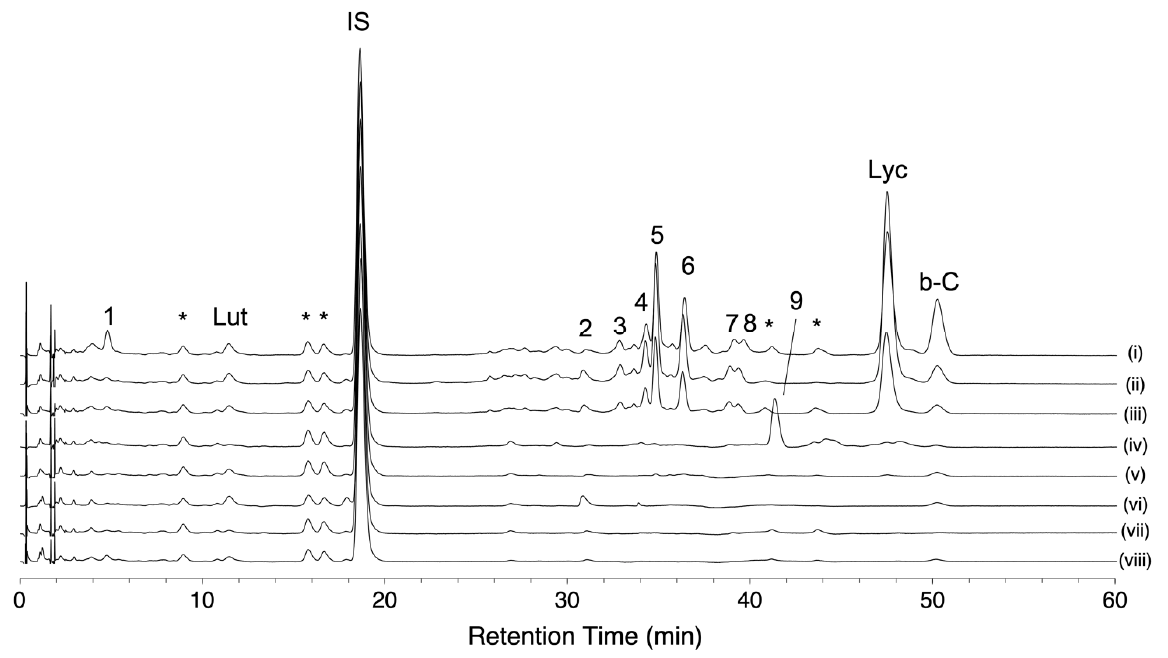
Figure 5. Carotenoid profiles of eight representative varieties analyzed by using HLPC-PDA. Carotenoid profiles were visualized at the wavelength of 450 nm. Each chromatogram shows the pattern of “Ailsa Craig” ( i ), “Bear Creek” ( ii ), “Chocolate Cherry” ( iii ), “Dixie Golden Giant” ( iv ), “Green Gage” ( v ), “Green Zebra” ( vi ), “Lemon Drop” ( vii ), and “Poire Jaune” ( viii ). Lycopene (Lyc), beta -carotene (b-C), and lutein (Lut) were identified by comparison to authentic standards. Spectral characteristics of peaks No. 1–9 are shown in Table S5. Peaks with an asterisk are co-eluents that were not carotenoids (see Section 4 in detail).